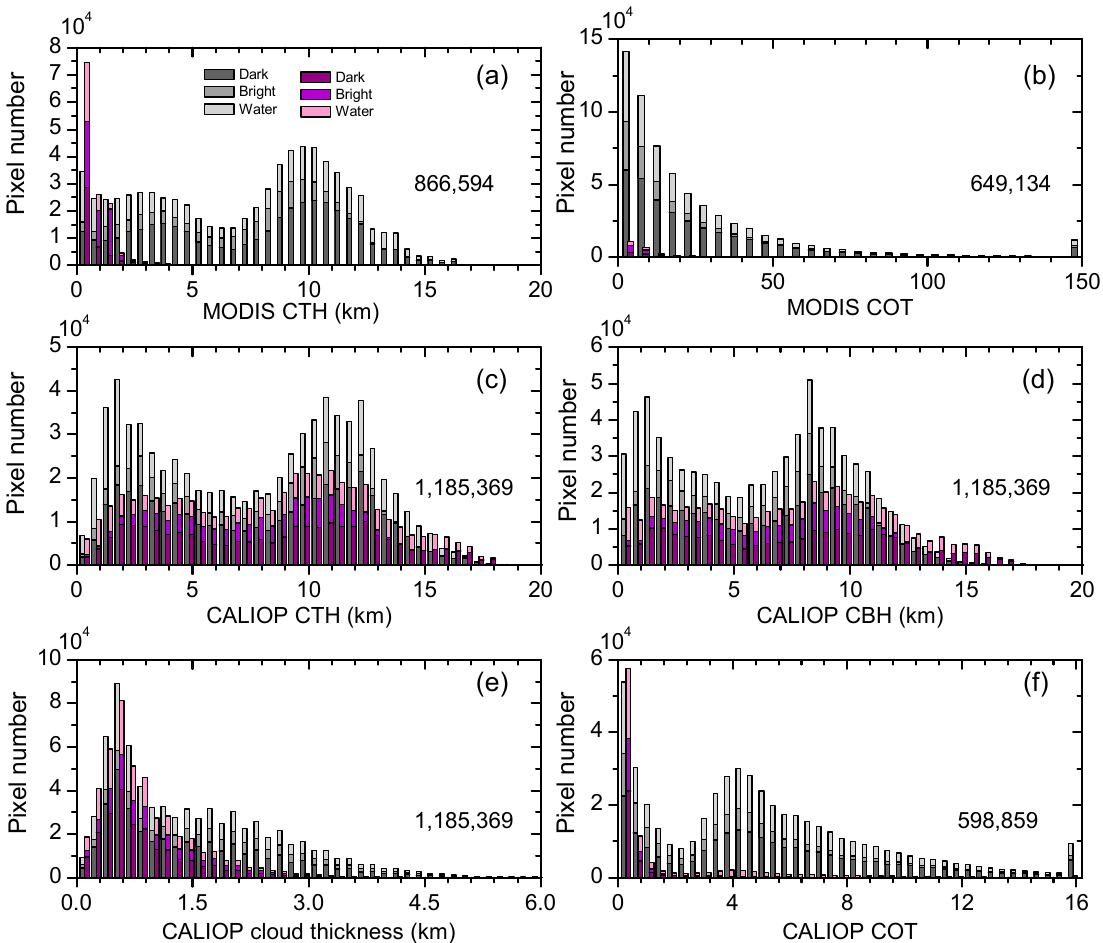
Figure 2. The histogram of total pixel numbers of consistent and non-consistent Moderate Resolution Imaging Spectroradiometer (MODIS) and Cloud–Aerosol Lidar with Orthogonal Polarization (CALIOP) cloud detection over dark, bright, and water surfaces along with ( a ) MODIS cloud top height (CTH); ( b ) MODIS cloud optical thickness (COT); ( c ) CALIOP CTH; ( d ) CALIOP cloud base height (CBH); ( e ) CALIOP cloud thickness; and ( f ) CALIOP COT. Gray and purple groups are consistent and non-consistent observations, respectively. Numbers shown on each panel are total pixel numbers.